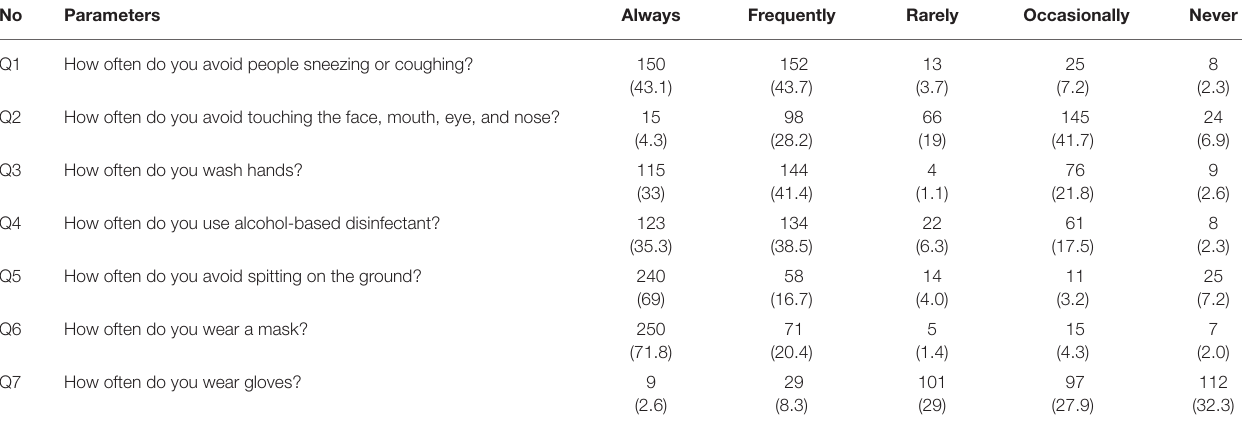
TABLE 3 | Participant responses toward ( n = 348) preventative measures and hygiene practice during the COVID-19 pandemic. No Parameters Always Frequently Rarely